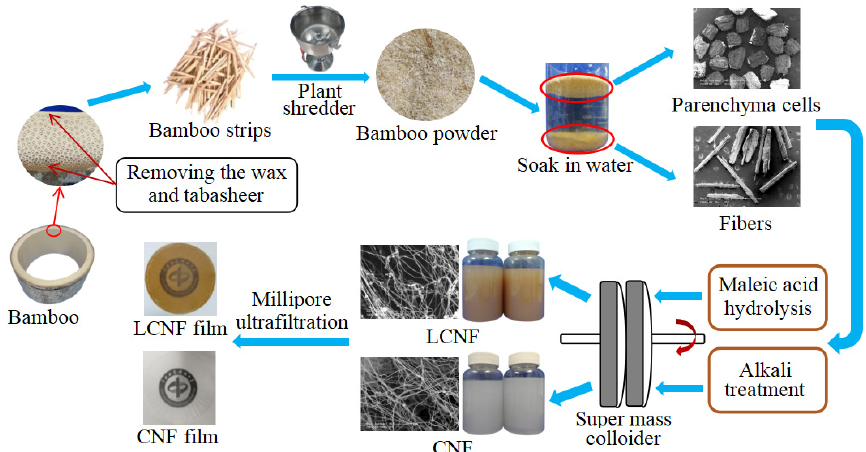
Figure 1. A schematic flow diagram of bamboo fibers and parenchyma cells for producing CNF (cellulose nanofibril) and LCNF (lignocellulose nanofibril) film.